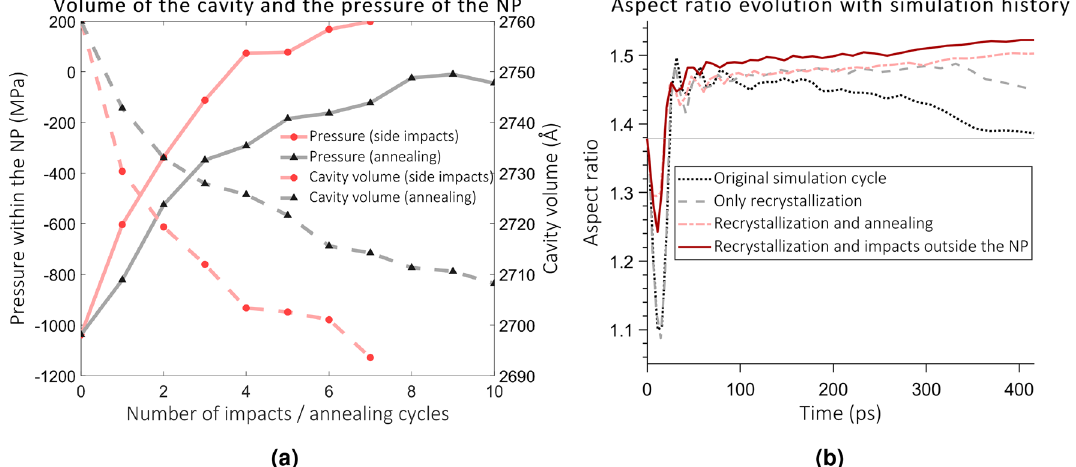
Figure 6. ( a ) The pressure and the cavity volume (void that would result by removing Au atoms) during impacts nearby. Also shown are the same results from an alternative annealing treatment. ( b ) Comparison of aspect ratio growth on the 11th impact using simulation cells with different